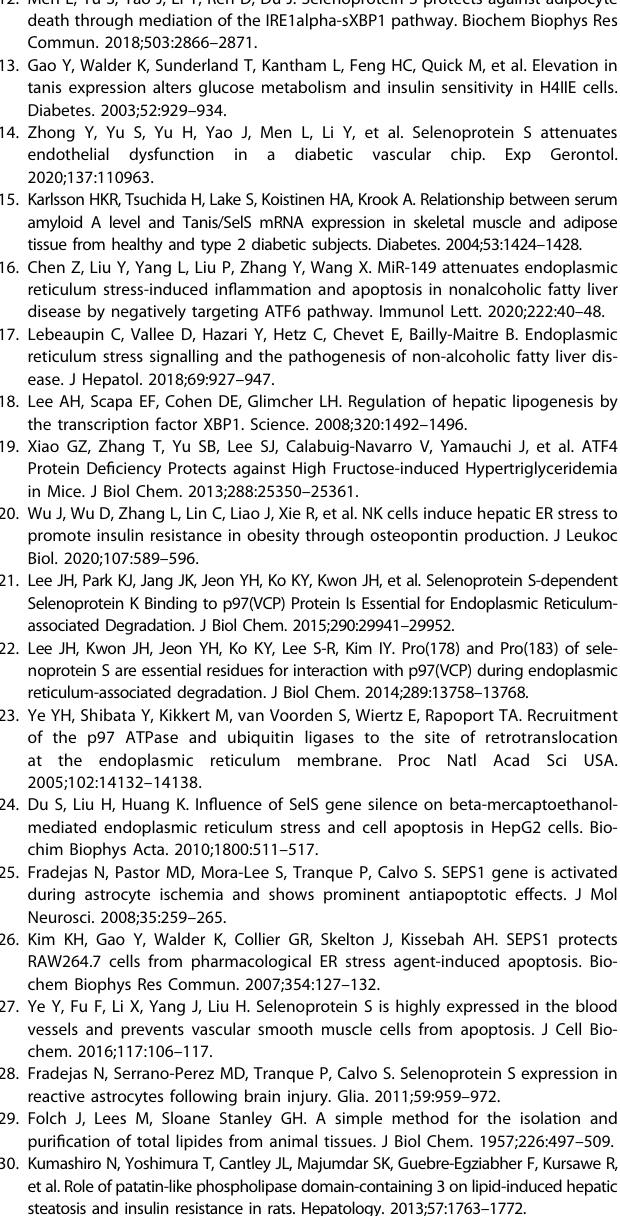
Fig. 7 Hepatic-speci fi c deletion of SelS decreases the production of hepatokine FGF21 and adipokine adiponectin and increases adipose tissue size. A , B Serum FGF21 concentrations ( A ) and Fgf21 mRNA expression ( B ) in the liver of 24-week-old SelS H-KO and SelS F/F mice fed with RC or HFD for 20 weeks ( n = 6 or 4 per group). C AT weight/body weight ratio of the indicated groups ( n = 10 – 15 per group). D Representative images of sWAT and eWAT isolated from mice of the indicated groups. Scale bar, 1 cm. E H&E staining of sWAT and eWAT in the indicated groups. Scale bar, 50 μ m. F Quanti fi cation of adipocyte area of sWAT and eWAT in the indicated groups ( n = 5 per group). G Serum adiponectin concentrations in the indicated groups ( n = 6 per group). H Relative mRNA expression of Adiponectin , Ppar γ and C/ebp α in sWAT of the indicated groups ( n = 4 per group). I Western blotting analysis of SelS and adiponectin protein levels in the mature mouse adipocytes, which were treated with different concentrations of recombinant mouse FGF21 for 24 h. The experiments are repeated for fi ve times. J Representative Western blotting images from one sample out of 3 for each group and quanti fi ed protein levels of SelS and adiponectin after mature mouse adipocytes were stimulated with FGF receptor-1 (FGFR1) inhibitor (PD166866, 10 μ M) or DMSO for 1 h, and subsequently treated with different concentrations of recombinant mouse FGF21 for 24 h ( n = 3 per group). K Schematic illustration of hypothesized mechanisms. All data are presented as the mean ± SEM. * P < 0.05, ** P < 0.01, *** P < 0.001. RC, regular chow; HFD, high-fat diet; SelS H-KO